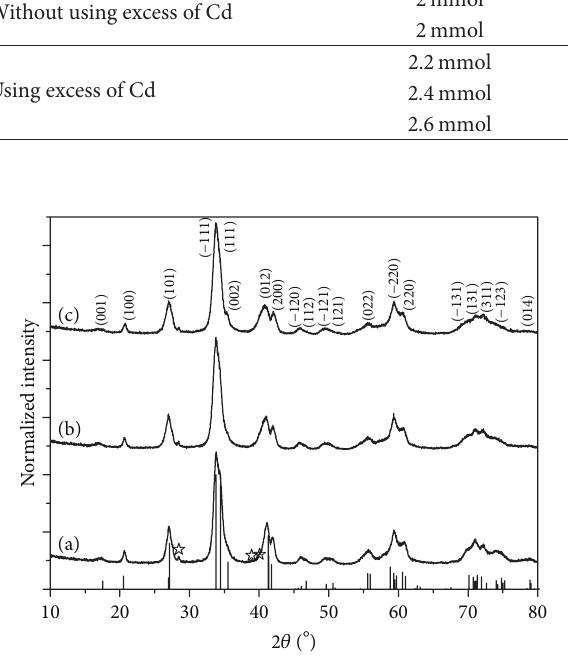
Figure 2: XRD patterns of the samples prepared with reagents out of stoichiometric proportion: (a) 10% excess of CdO, (b) 20% excess of CdO, and (c) 30% excess of CdO. Bars represent the wolframite structure of CdWO 4 (some crystalline planes are indexed according to [26]) and symbols correspond to WO 3